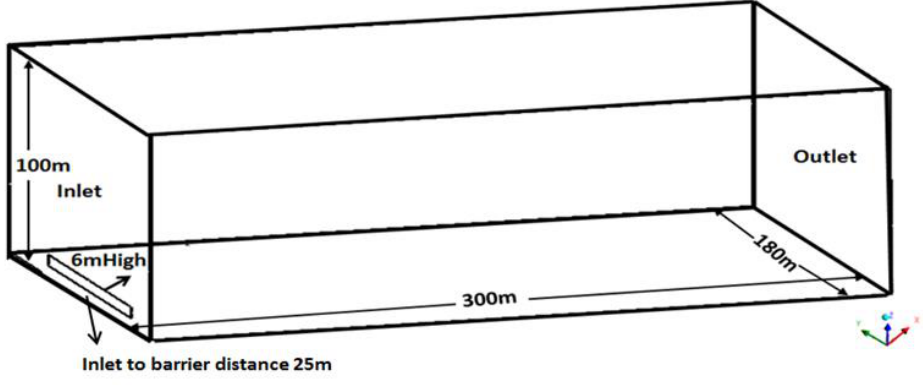
Figure 2. Wind profile validation computational domain.